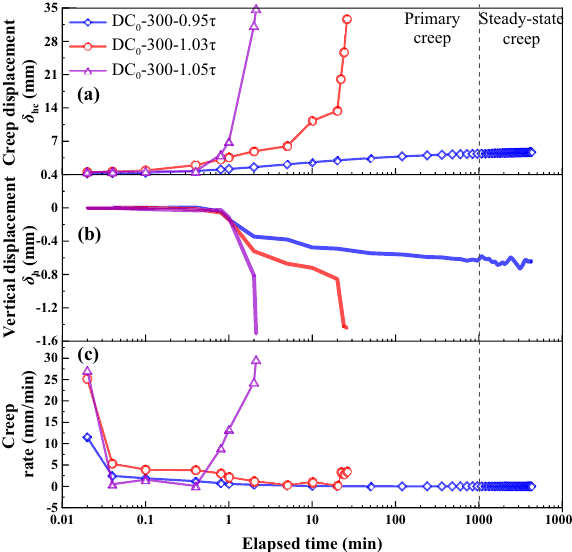
Figure 11. Relationships of ( a ) creep displacement ( δ hc ) versus elapsed time, ( b ) vertical displacement ( δ vc ) versus elapsed time, and (c) creep rate versus elapsed time for the unreinforced specimens at ω = 18% under σ n = 300 kPa.